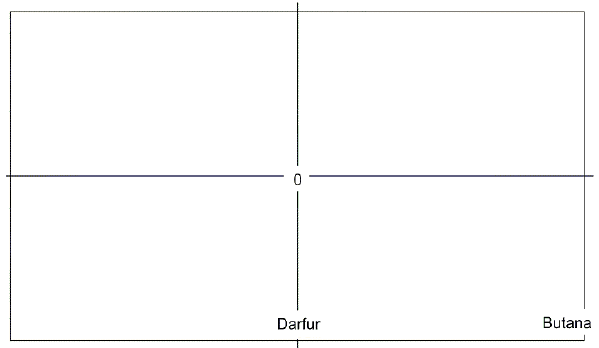
Figure 2. Principal component analysis (PCA) of the two major Sudanese camel ecotypes.